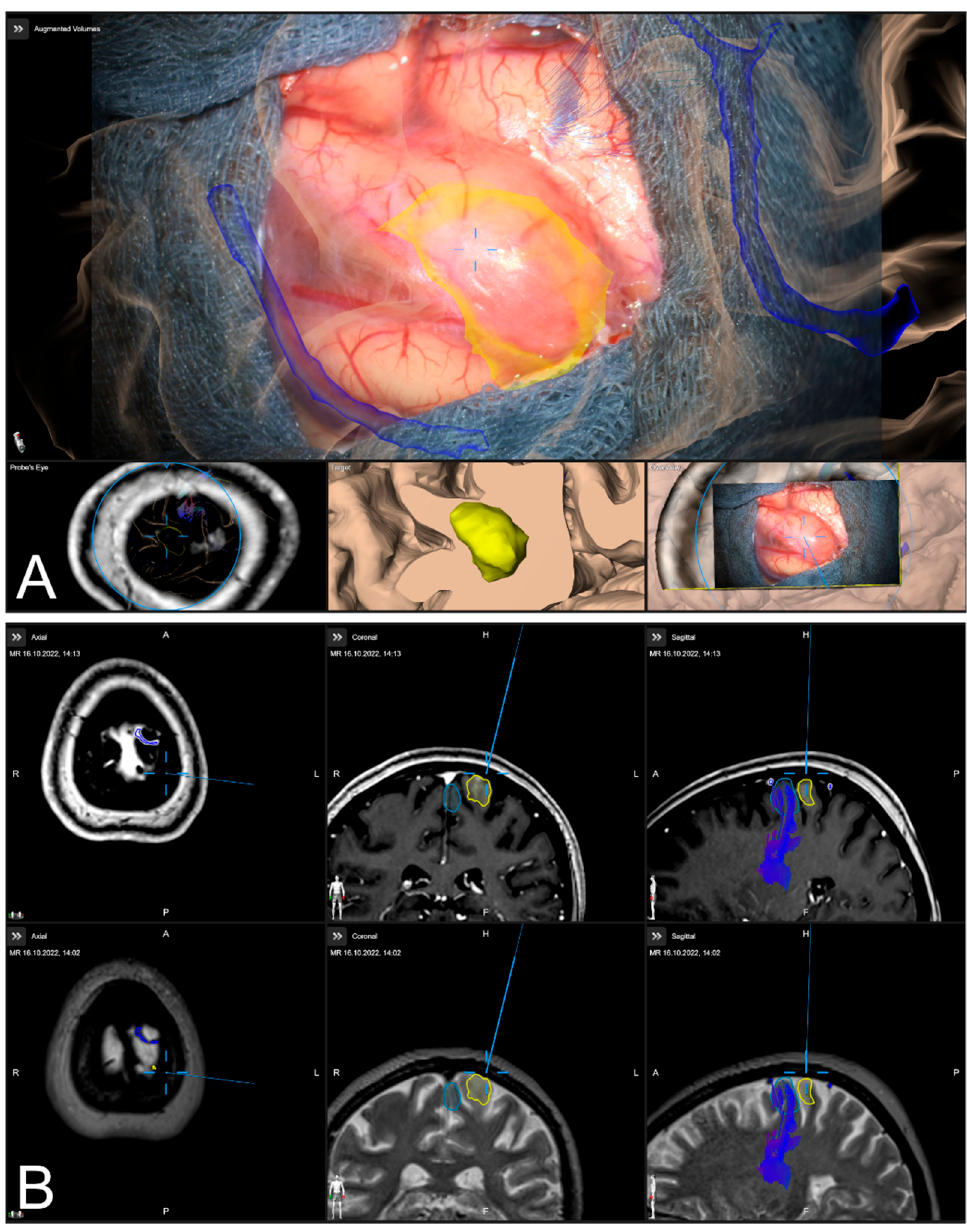
Figure 3. After calibration of the microscope, besides HUD-based visualization within the micro- scope, the Microscope Navigation Element ( A ) and Cranial Navigation element ( B ) are displayed on monitors close to the surgical field. The microscope application allows for a visualization of outlined objects (yellow: tumor, blue: precentral gyrus, corticospinal tract) superimposed on the microscope video ( A , top), or probe’s eye view, target view or outlined 3D anatomy in relation to the microscope video frame ( A , bottom, left to right). In parallel, in the navigation application multimodal fused image sets with outlined structures are visualized in, e.g., axial, coronal, and sagittal view ( B ).